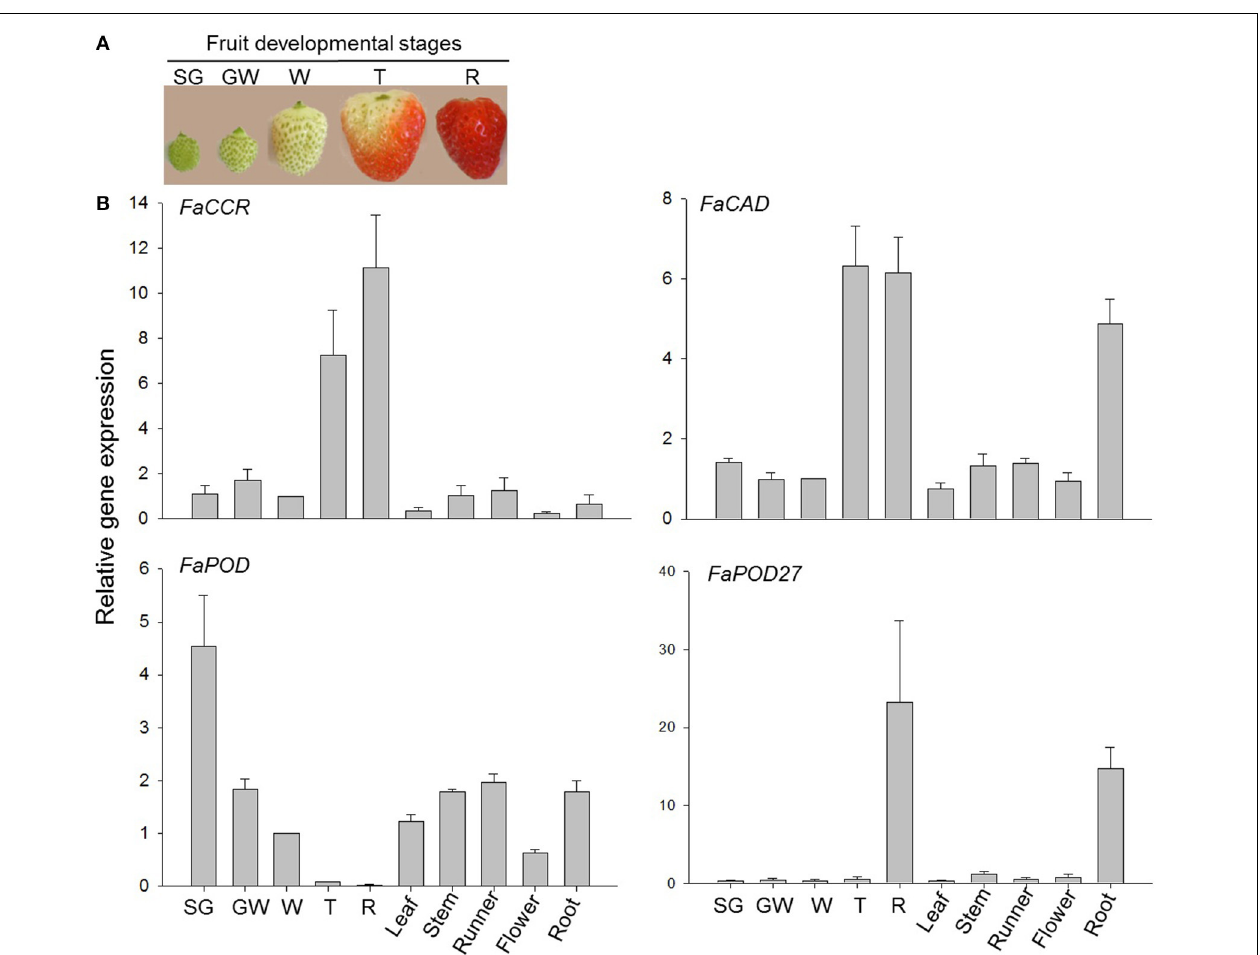
FIGURE 2 | Relative expression profiles of monolignol biosynthesis genes in vegetative tissues, flowers, and fruit developmental stages of F . × ananassa cv. Elsanta. Total RNA was isolated from (A) fruit developmental stages at small green (SG), green white (GW), white (W), turning (T), and red (R) after pollination. (B) Expression levels of vegetative